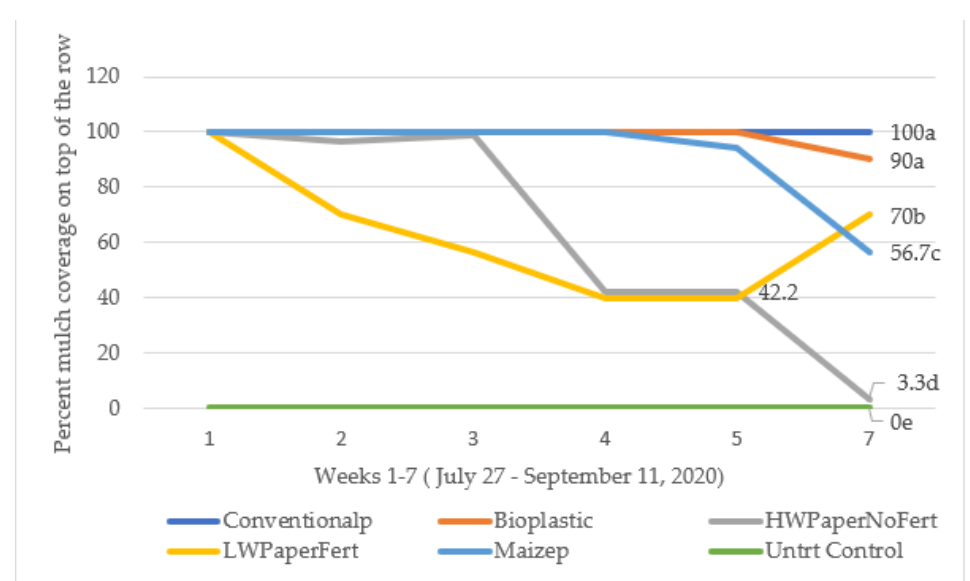
Figure 3. Mulch coverage throughout the study at the Beaumont, MS location. Mulch treat- ments with different letters are statistically significant at p ≤ 0.05 using SAS Proc GLM with Duncan. Unttrt Contol = un-mulched raised beds; Maize p = biodegradable maize plastic mulch; Bioplastic = biodegradable bioplastic mulch; Conventional p = polyethylene black plastic mulch; HW Paper No Fert = heavy weight paper mulch without impregnated fertilizer; LW Paper Fert =